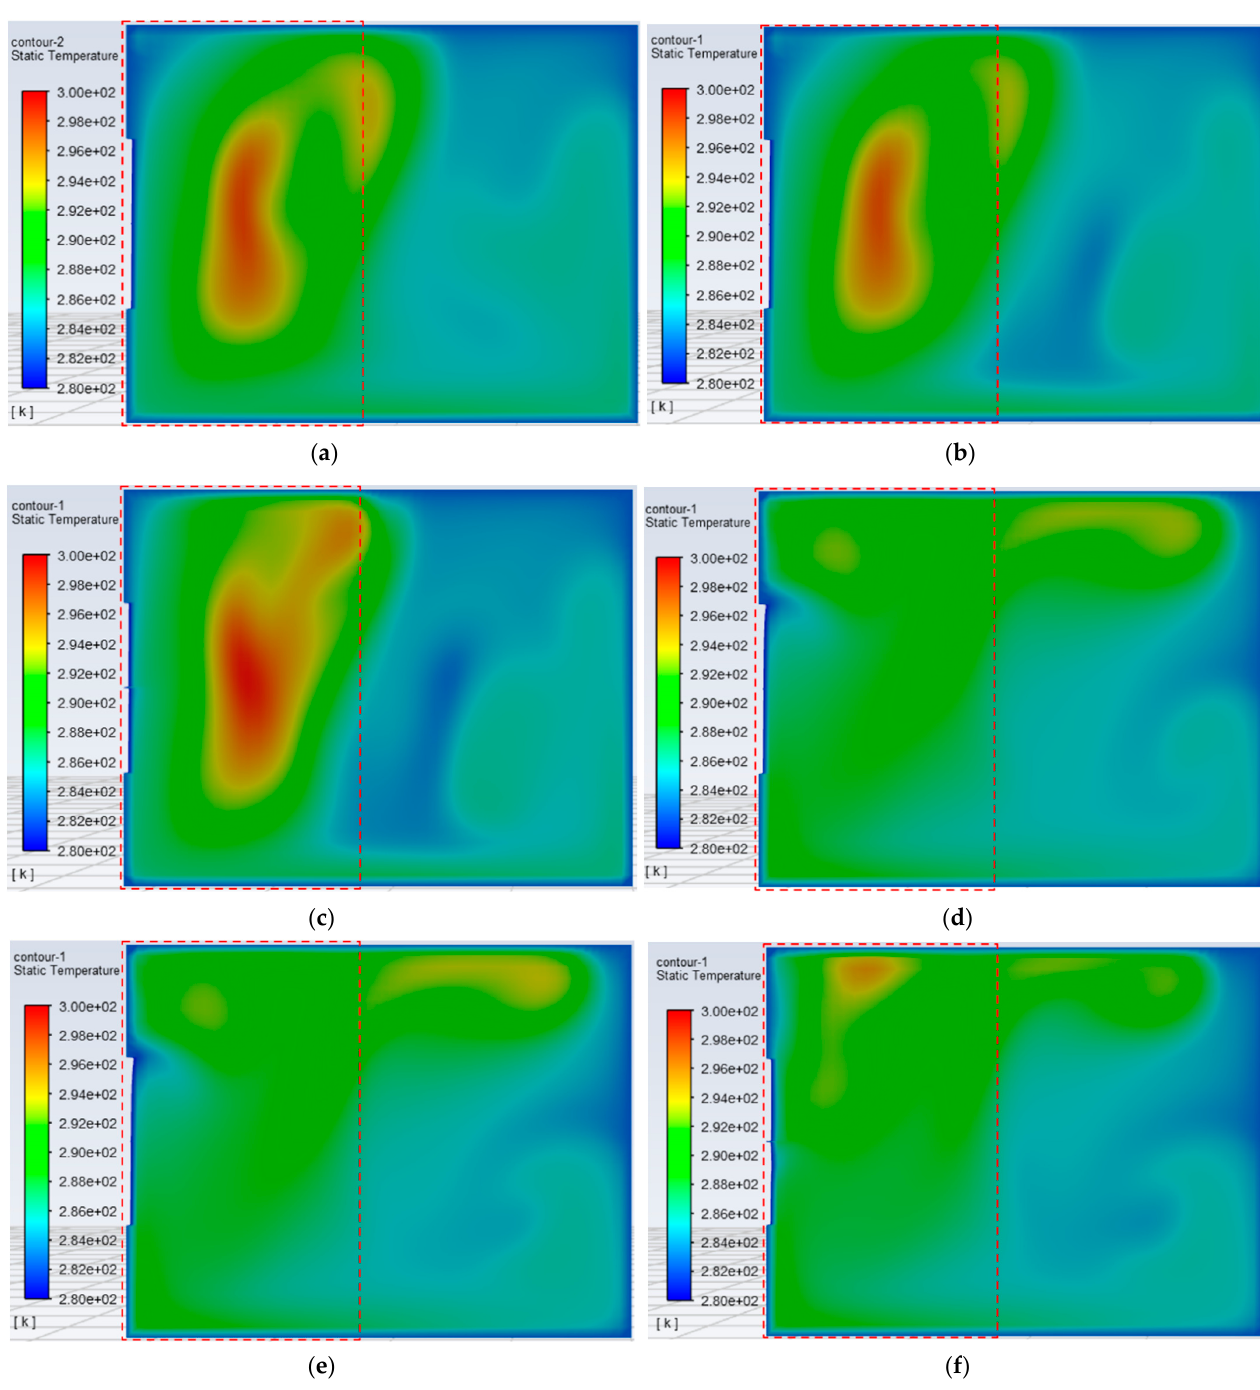
( f ) Figure 15. Contours of indoor 1.2 m high plane air velocity distribution under six schemes: ( a ) MOUSLE, ( b ) MSUSLE, ( c ) MUSEWP, ( d ) DOUSLE, ( e ) DSUSLE, ( f ) DUSEWP. Table 7. The average air velocity on the kang side and the floor side when the ventilation volume is Q = 141 m 3 /h.